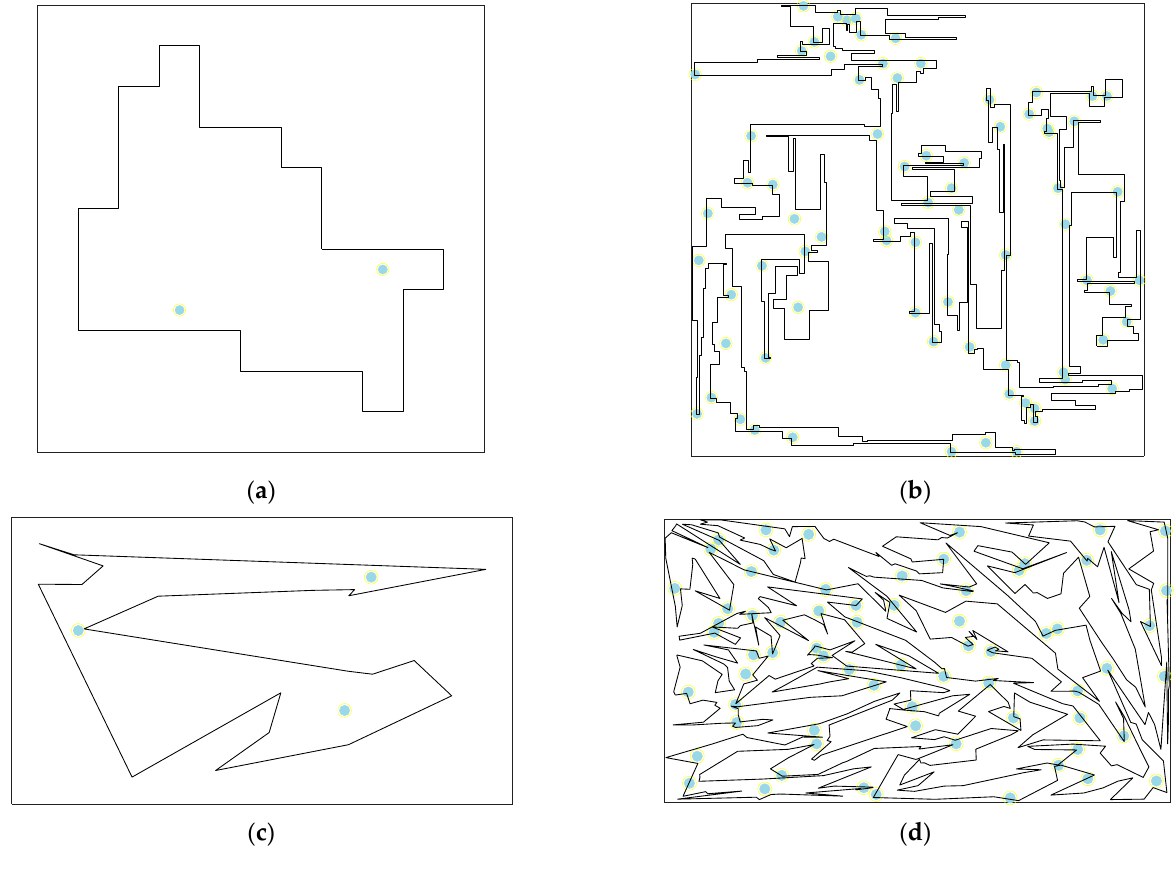
Figure 10. The WGA viewpoint planning results for the sample polygons. ( a ) Random orthogonal polygons with 20 vertices (instance #20-9); ( b ) random orthogonal polygons with 500 vertices (instance #500-4); ( c ) random simple polygons with 20 vertices (instance #20-4); ( d ) random simple polygons with 500 vertices (instance